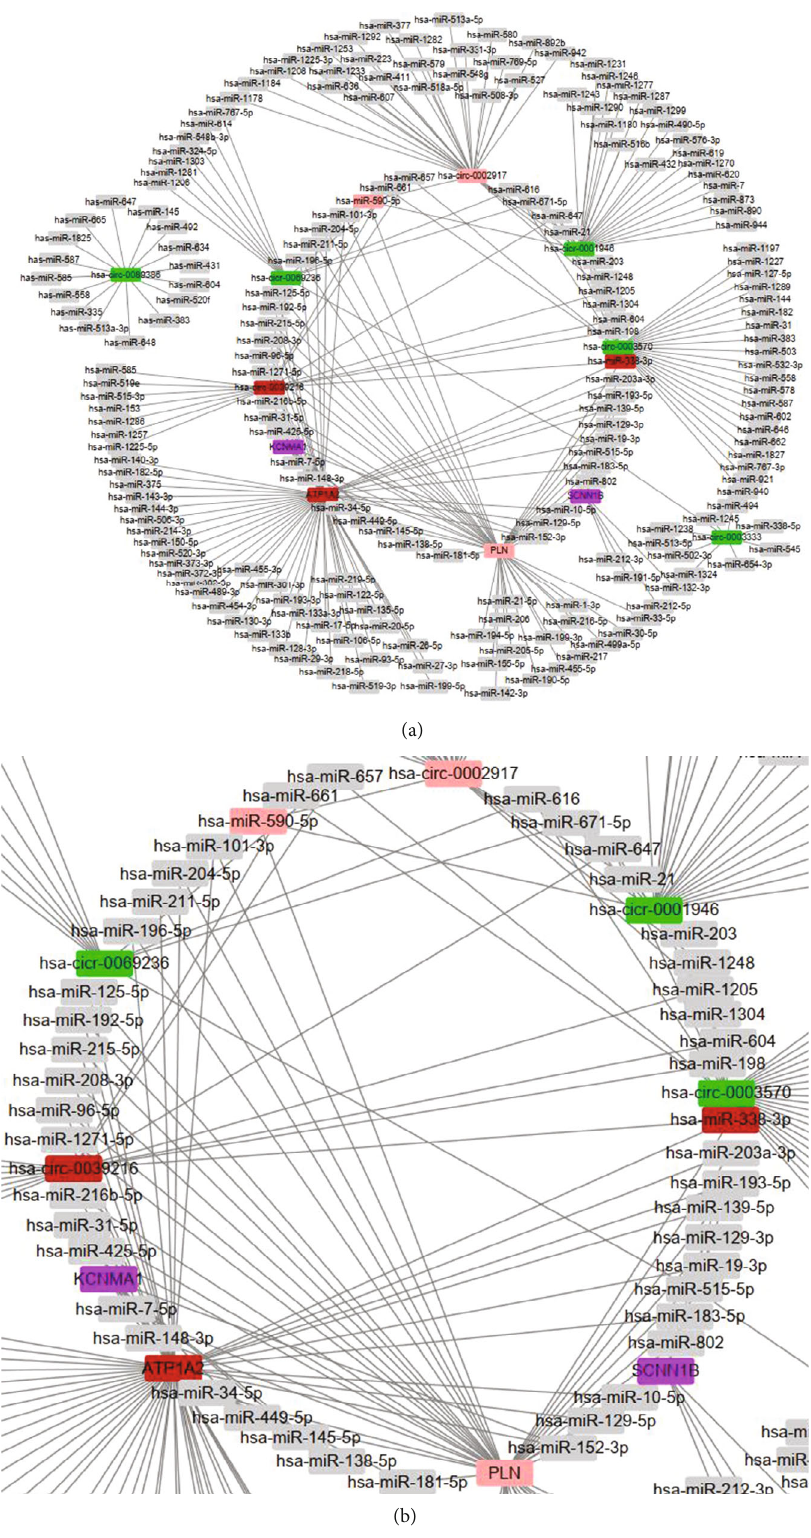
Figure 8: The circRNA-miRNA-mRNA regulatory network. (a) Overview of the entire network. (b) Speci fi c relationship between circRNAs, miRNAs, and mRNAs in the network. Red represents hsa-circ-0039216/hsa-miR-338-3p/ATP1A2. Pink represents hsa-circ-0002917/hsa- miR-590/PLN. Purple represents DEGs. Green represents